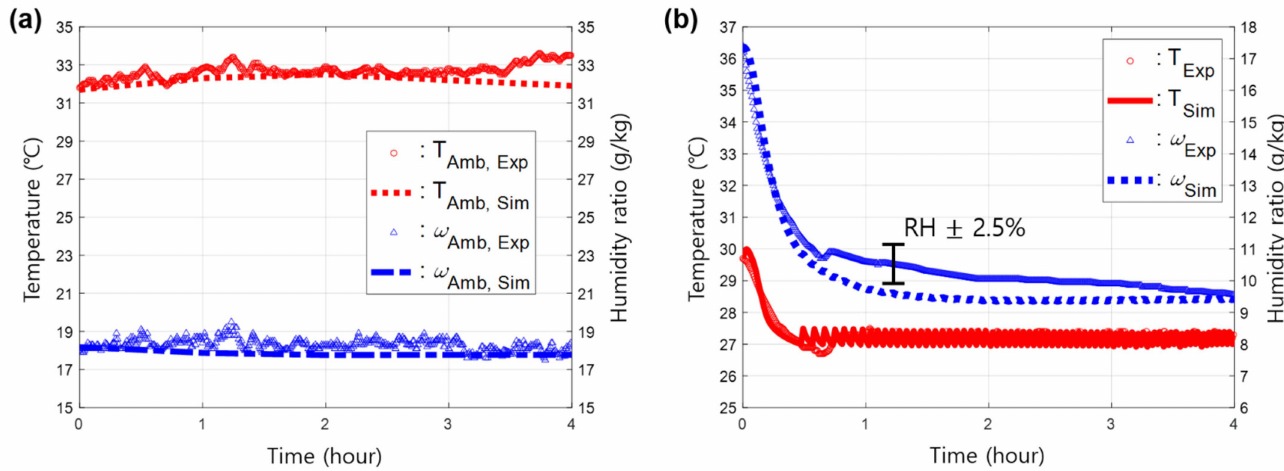
Figure 7. Validation of simulation model: ( a ) outdoor conditions and ( b ) temporal variation of the temperature and humidity in the meeting